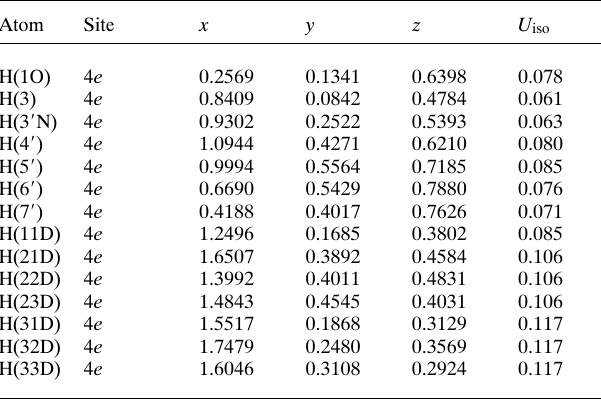
Table 2. Atomic coordinates and displacement parameters (in Å 2 )